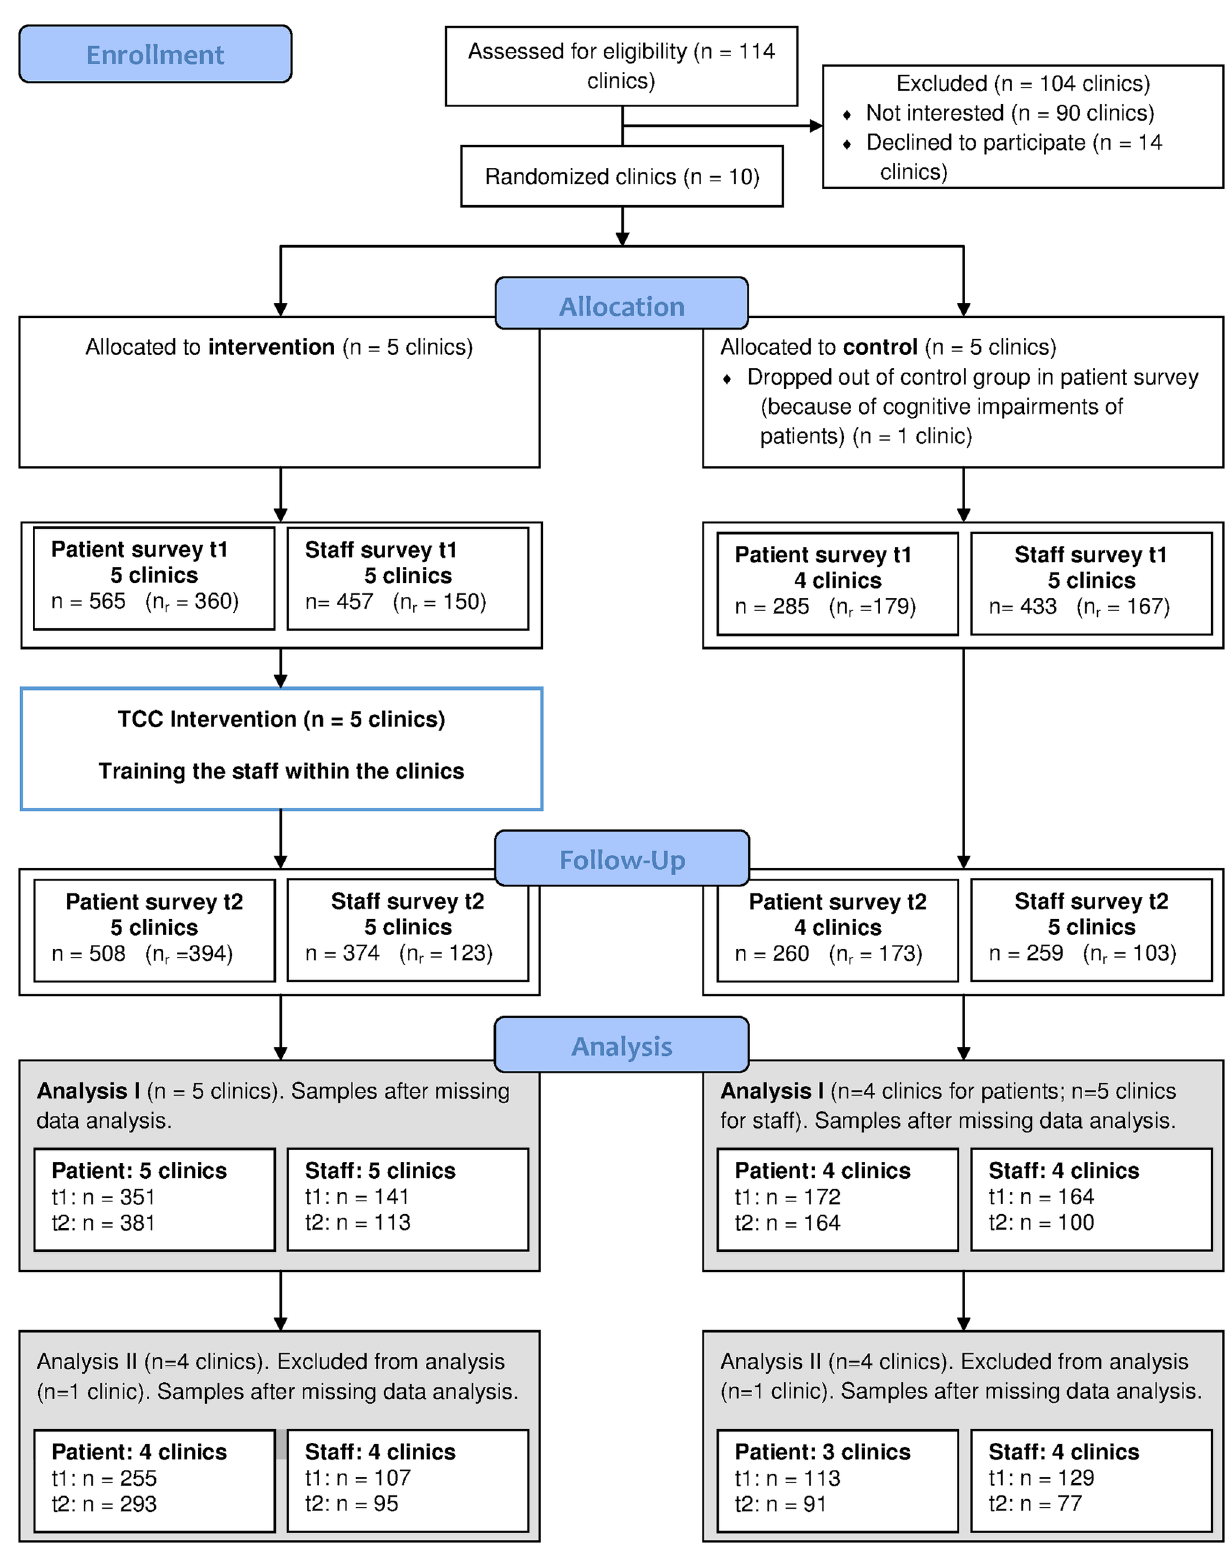
Fig 2. Flowchart study process. Legend :n=number of questionnaires sent to clinics, (nr)=number of questionnaires returned, t1=pre- intervention, t2=post intervention, TCC=Team CoachingConcept.